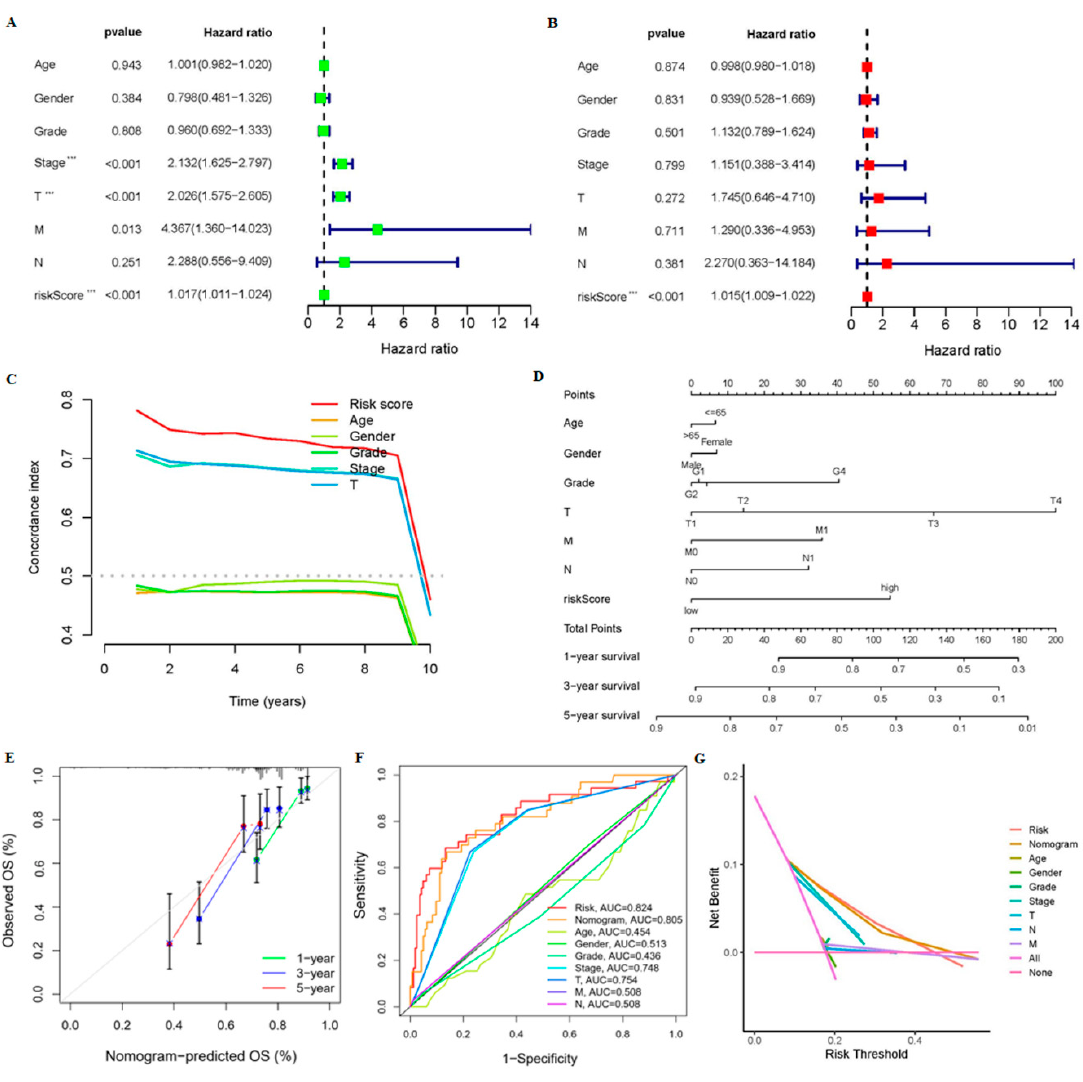
Figure 5. Evaluation of the predictive ability of the 9-crLncrNA prognostic model. The univariate ( A ) and multivariate ( B ) Cox regression analyses were performed to evaluate the independent predictive potential of OS of the risk score and relevant clinical characteristics. *** p < 0.001. ( C ) The C-index was used to evaluate the predictive power of the model. ( D ) The nomogram was used for the prediction of 1-, 3-, and 5-year survival. ( E ) The calibration curves were used to examine the capability of predicting the OS at 1, 3, and 5 years. ( F ) The multi-indicator ROC curve and ( G ) the DCA curve were used to evaluate the predictive ability of the nomogram and risk score.